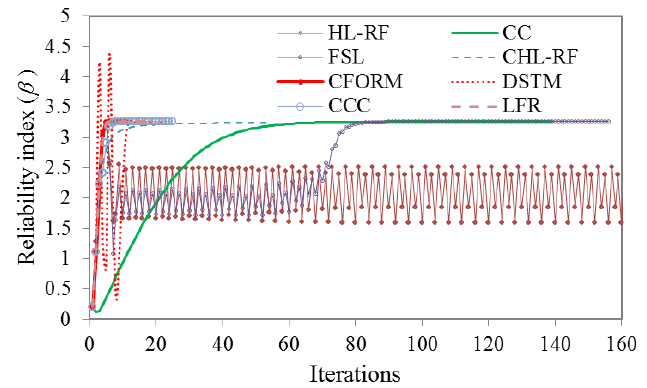
Figure 2. Iterative histories of HL-RF, FSL, CC, DSTM, CCC, LFR, CFORM, and CHL-RF in solving Example 1.